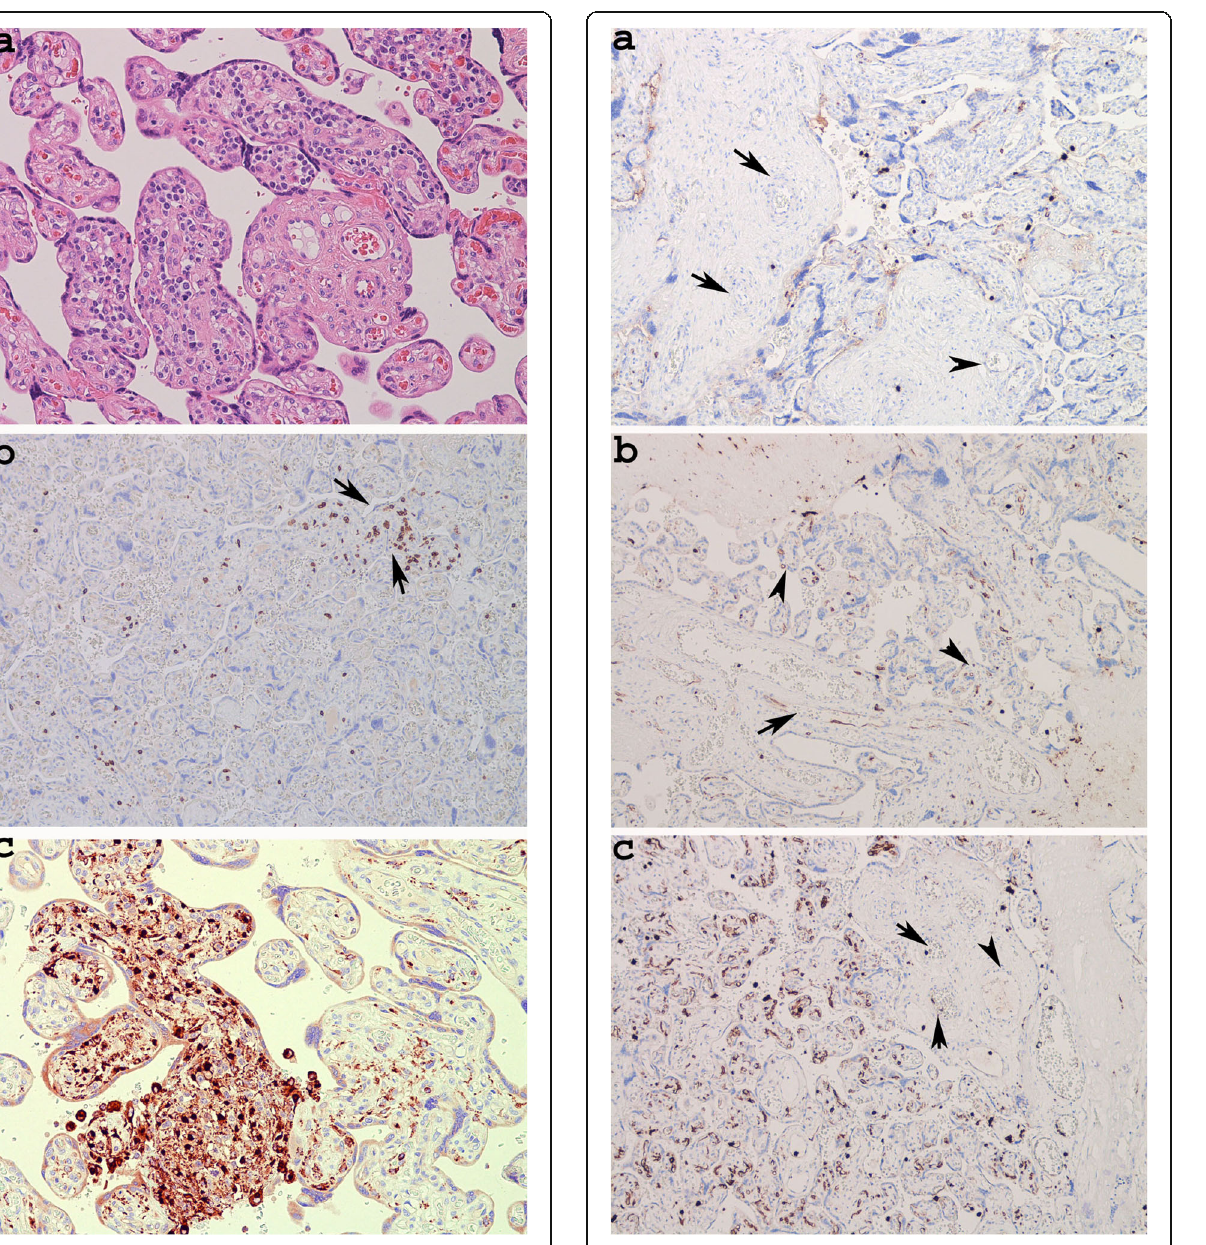
Fig. 4 Chronic villitis ( a Case 5, haematoxylin and eosin stain × 200); positivity for CD8 demonstrating the presence of T cytotoxic lymphocytes in the inflammatory infiltrate ( b × 100, Arrows: villi with immunoractivity for CD8) and positivity for CD68 in the histiocytic component ( d × 100)